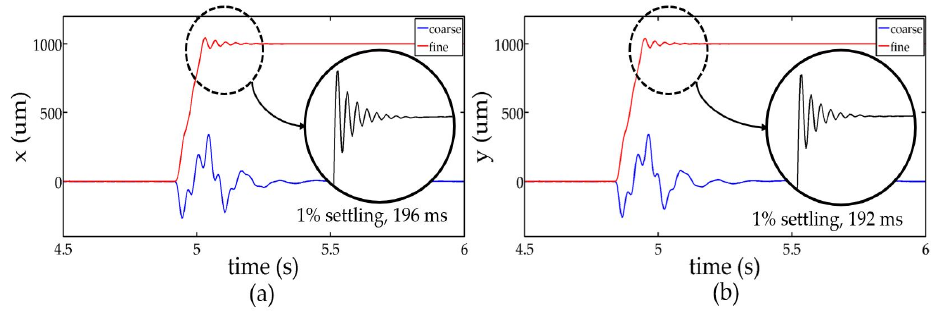
Figure 13. The evaluated settling time data of the dual servo stage: ( a ) x direction, ( b ) y